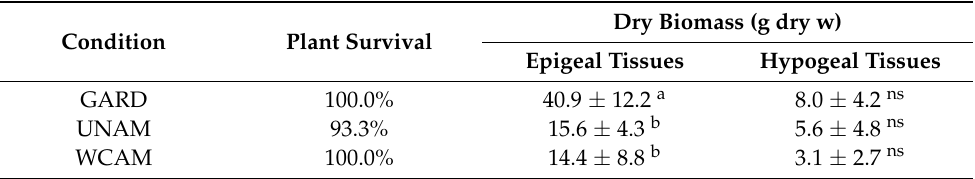
Table 1. Survival and dry biomasses of Helichrysum microphyllum subsp. tyrrhenicum at the end of the greenhouse